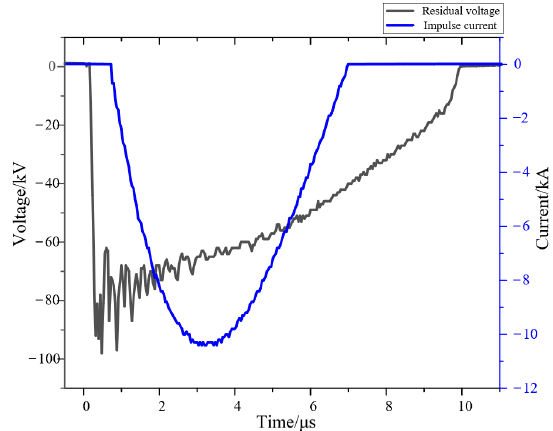
Figure 6. Impulse current and residual voltage